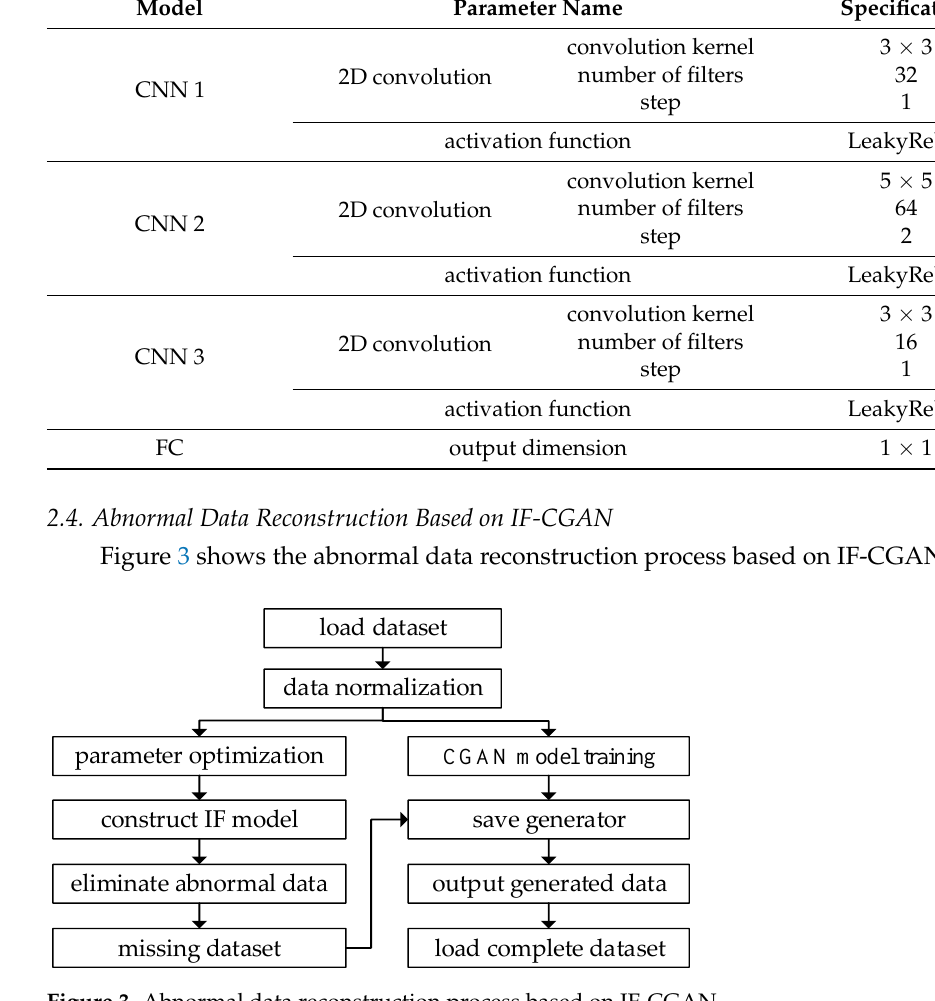
Figure 3. Abnormal data reconstruction process based on IF-CGAN.